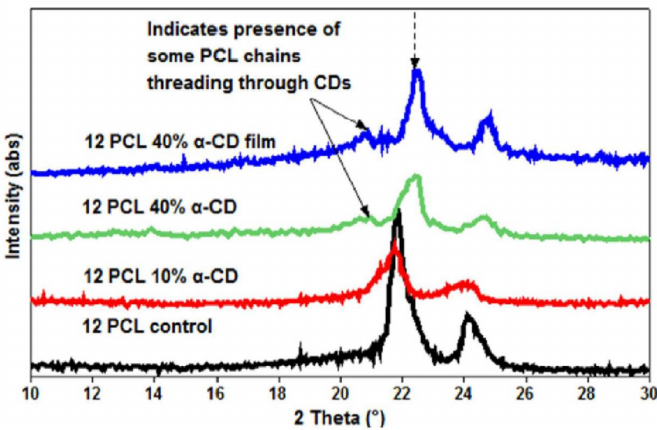
Figure 4. Wide-angle diffraction (WAXD) patterns of the electrospun PCL, α -CD functionalized electrospun PCL nanofibers, and PCL- α -CD film cast from solution. Neat PCL showed two peaks at 22 ◦ and 24 ◦ 2 θ corresponding to (110) and (200) reflections. While the lack of any additional peaks in 10% α -CD containing PCL nanofibers, the presence of an additional peak at 20 ◦ 2 θ and shifts in the PCL peaks, indicate the presence of some inclusion complex between PCL and α -CD. Images adapted and reproduced from [42]. Copyright American Chemical Society 2014.